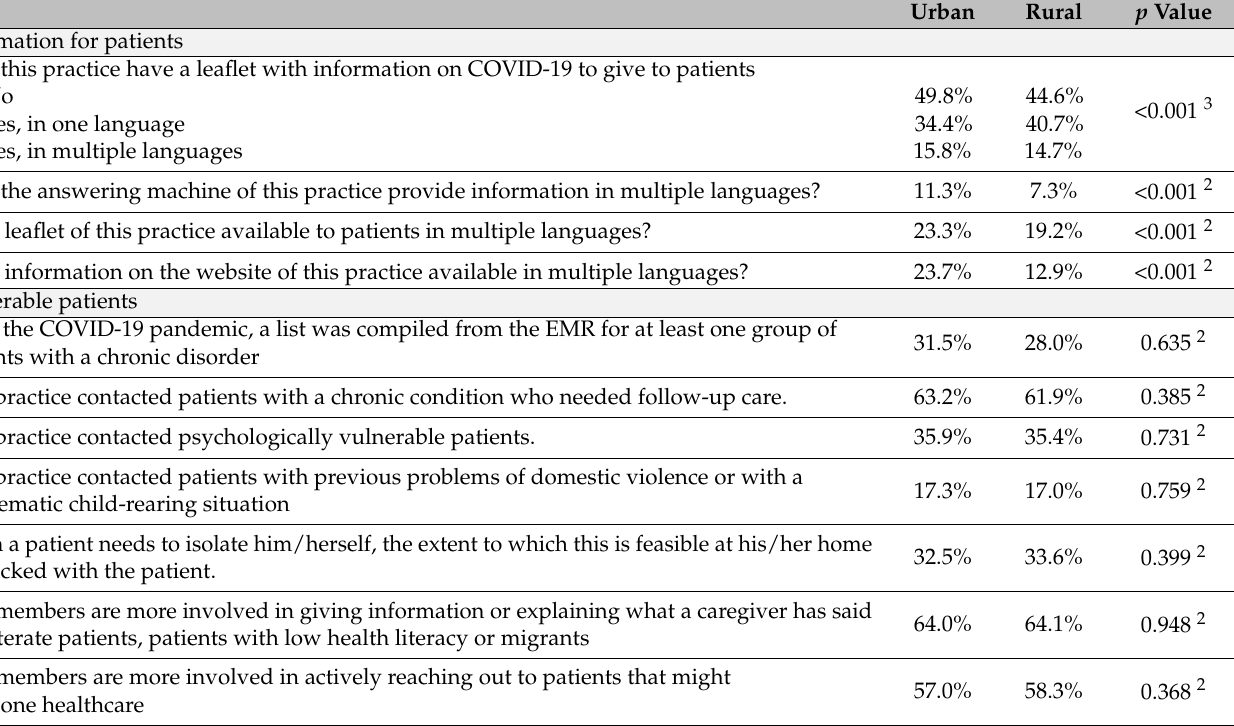
Table 3. Information for patients and taking care of vulnerable patients ( n = 5539).